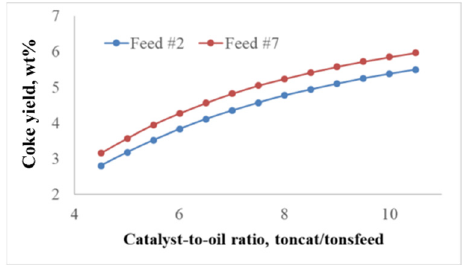
Figure 10. Effect of the catalyst-to-oil ratio on coke yield.